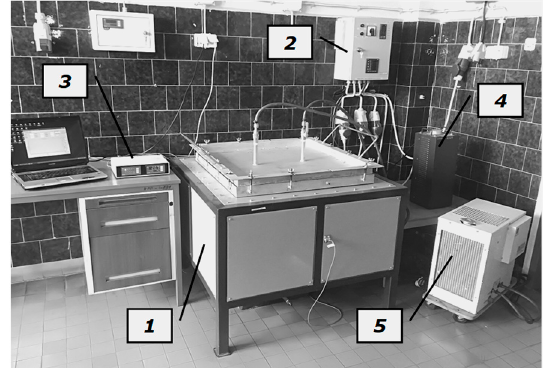
Figure 3. A general view of the testing stand: 1—heating chamber; 2—control unit for the main and guarded heaters; 3—data logger with temperature meter; 4—autotransformer; 5—cooling system unit.